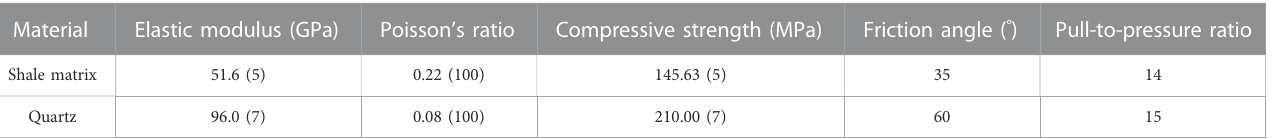
TABLE 1 Material parameters of shale